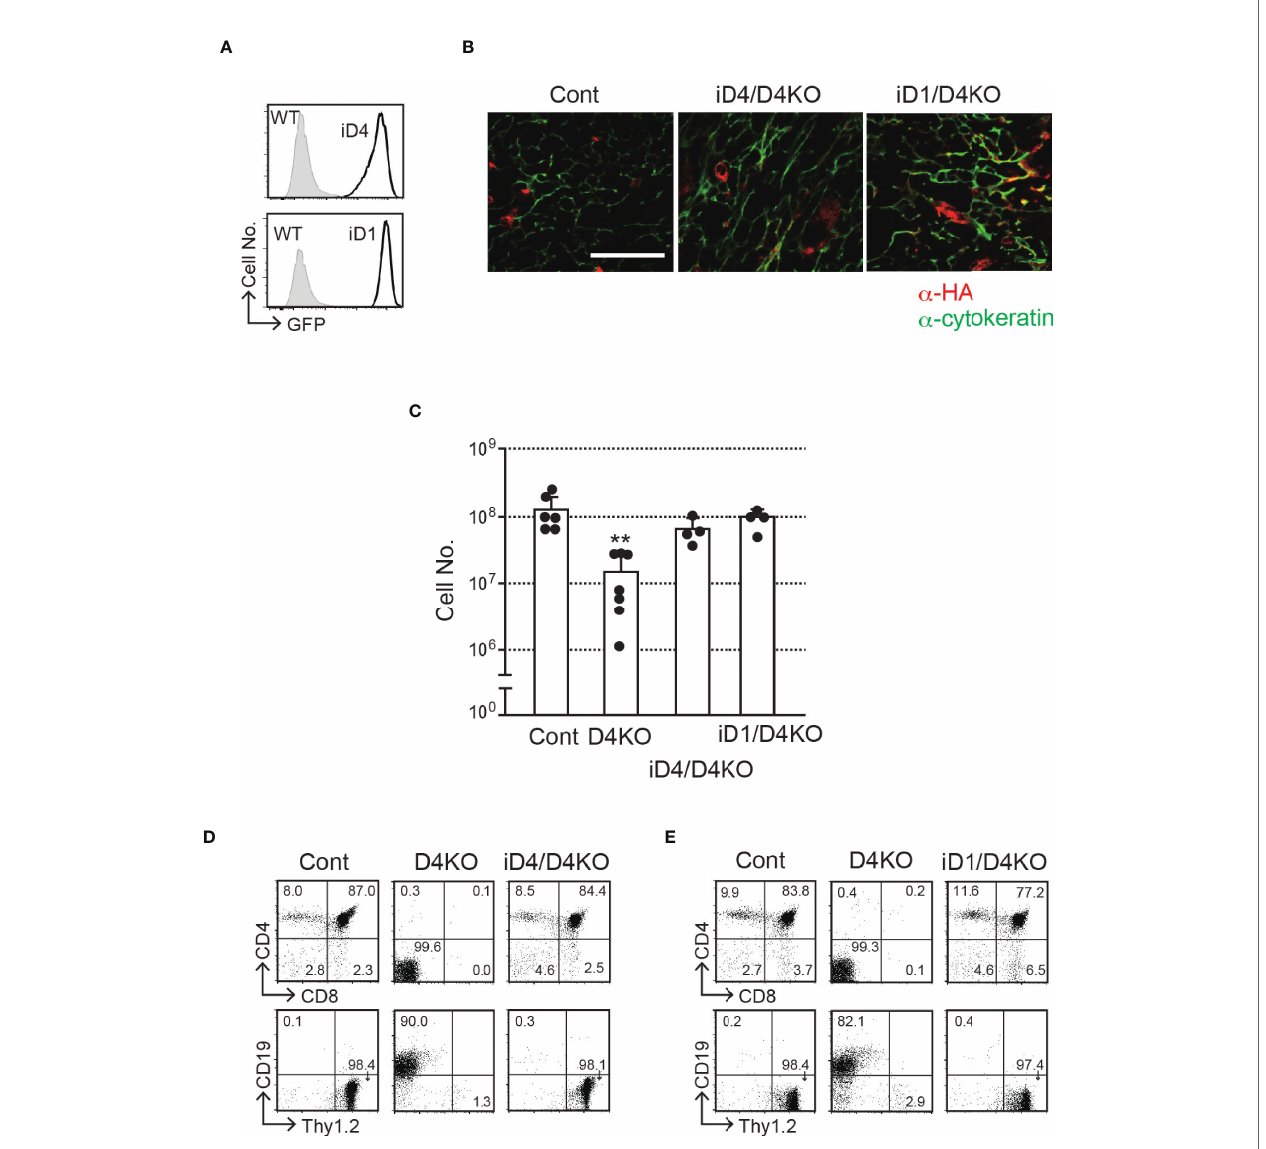
FIGURE 2 | T-cell development in the thymus with epithelial cells expressing exogenous Dll4 or Dll1 in Dll4 -de fi cient background. (A) GFP expression, transcripts driven by CAG promoter at the Rosa26 locus of iD1 and iD4 mice, was detected in EpCAM + PDGFR a - epithelial cells obtained from fetal (E15.5) thymus using fl ow cytometry. Open histograms indicate GFP expression of Rosa26 fl oxedGFP-Dll4 (iD4) or Rosa26 fl oxedGFP-Dll1 (iD1) mice, and fi lled histograms indicate the intrinsic fl uorescence of the identical cell population of control (WT) mice. (B) Representative results of immuno fl uorescence microscopy analysis of the thymus from Dll4 f/f (Cont), iD4 Dll4 f/ f FoxN1-Cre (iD4/D4KO), or iD1 Dll4 f/f FoxN1-Cre (iD1/D4KO) mice stained with anti-HA (red) and anti-cytokeratin (green) antibodies are shown. Intense and widespread red staining (anti-HA Ab) were nonspeci fi c staining. Scale bar: 50 m m. (C) Thymic cellularity (mean ± SD) of 8- to 12-week-old Dll4 f/f (Cont, n=6), Dll4 f/f FoxN1-Cre (D4KO, n=7), iD4 Dll4 f/f FoxN1-Cre (iD4/D4KO, n=4), or iD1 Dll4 f/f FoxN1-Cre (iD1/D4KO, n=4) mice. **p<0.01 by Student ’ s t -test. (D, E) Flow cytometric analysis of thymocytes from the mice shown in panel (B) was performed. Thymocytes were stained with mAbs against surface molecules as indicated. Numbers in the pro fi les indicate the relative percentages for each quadrant. Results represent more than three independent experiments (A, B, D, E)